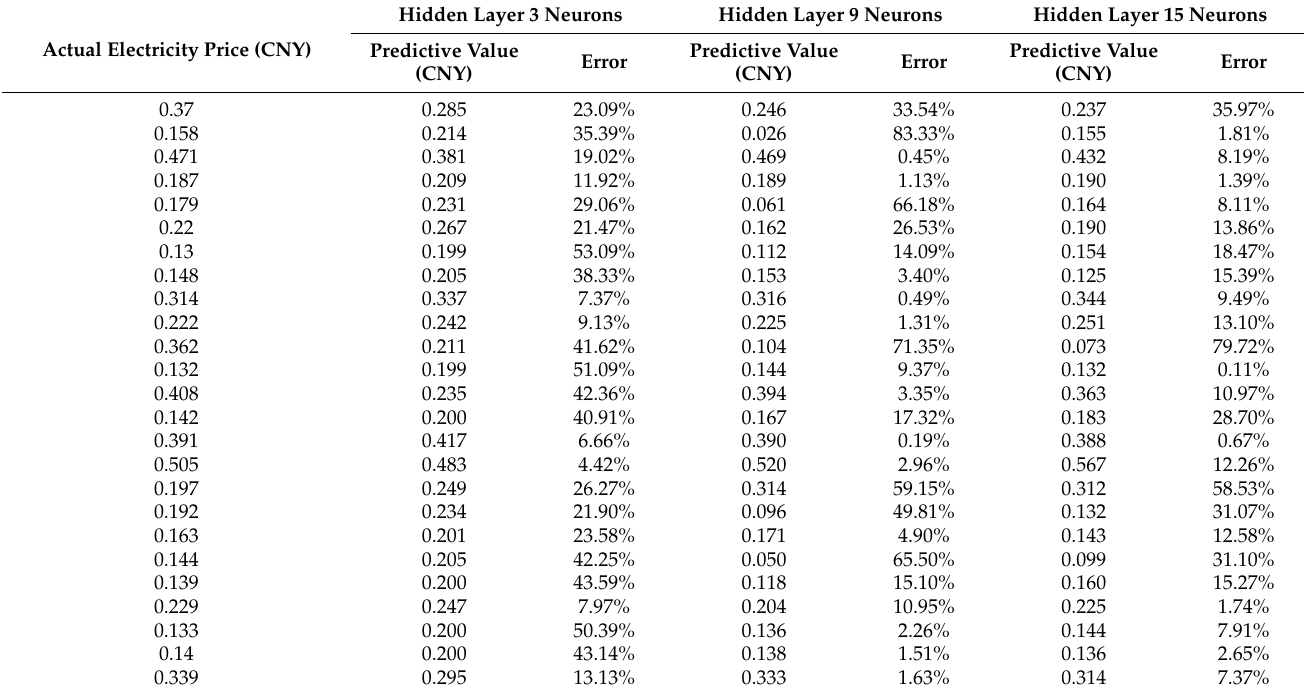
Table 4. Predictive value and error using